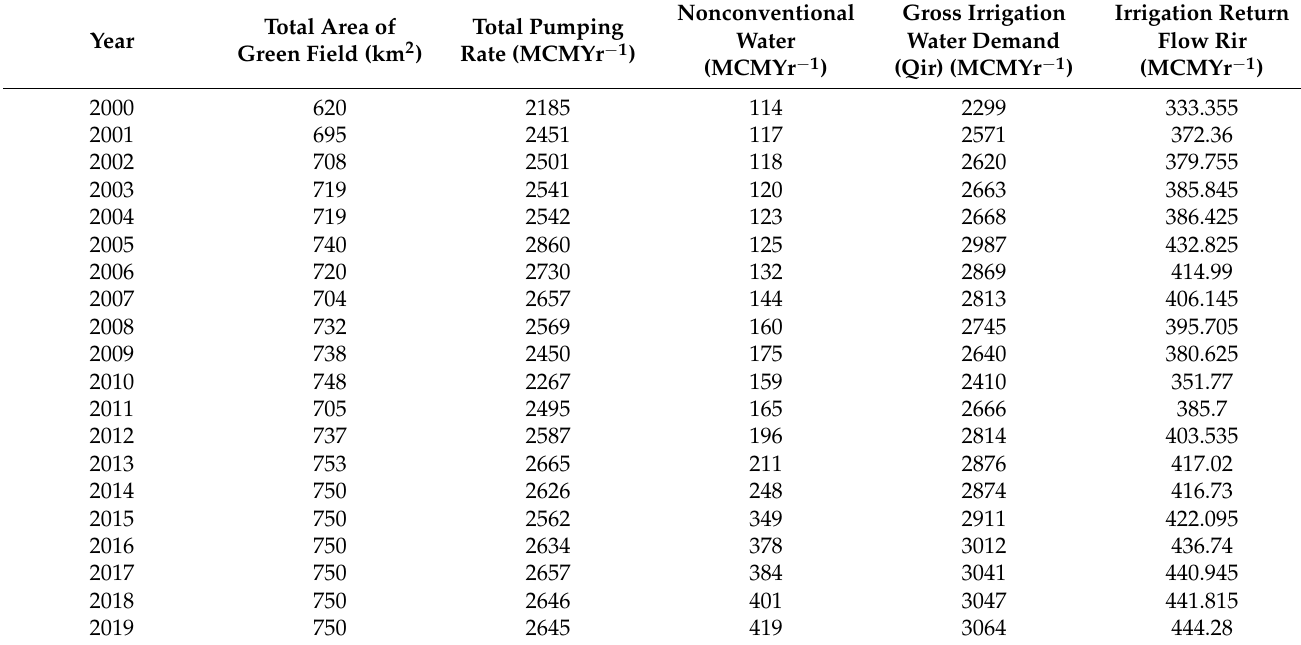
Table 1. Estimation rate of groundwater pumping and irrigation return flow (Rir)